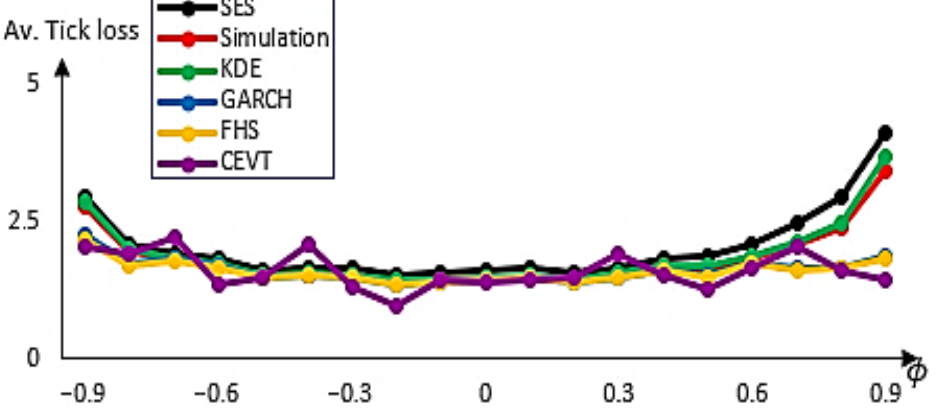
Figure 1. Average tick loss values for lead times of one week and when forecasting errors follow a lognormal distribution.